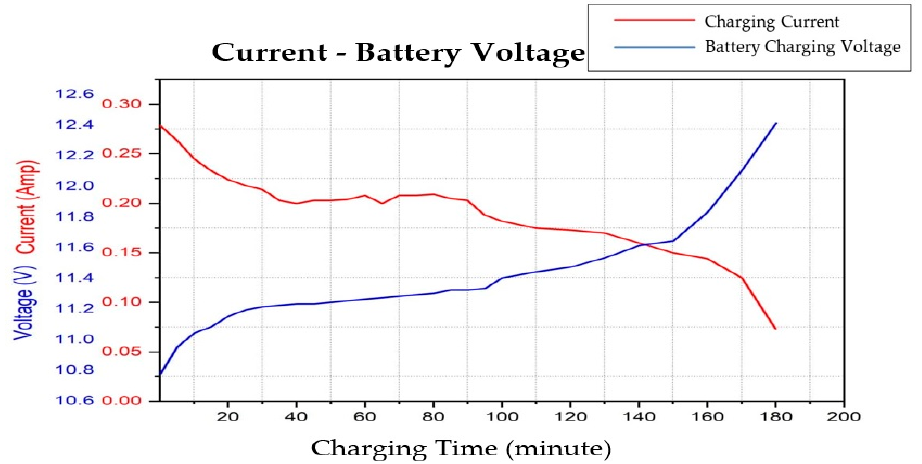
Figure 7. The current supply and battery voltage during charging.